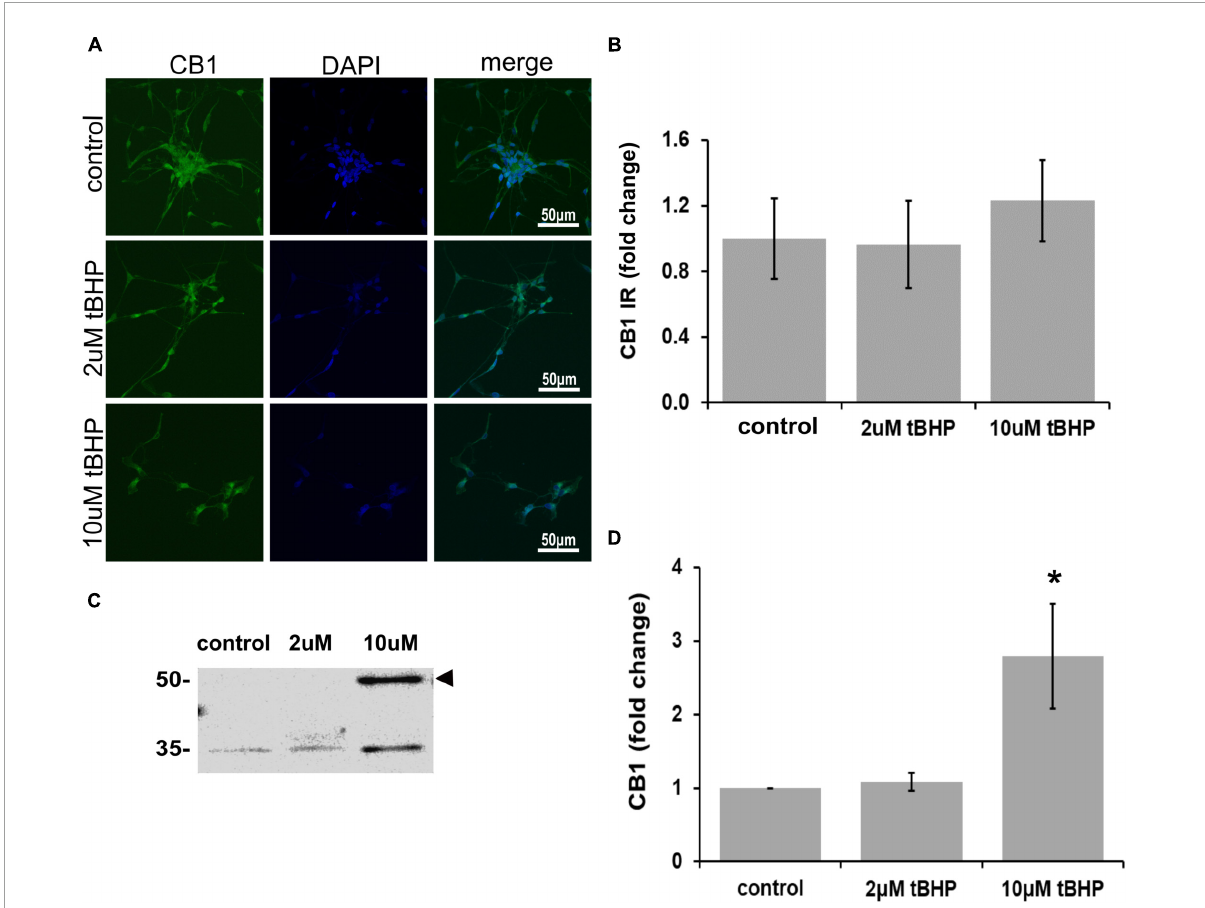
FIGURE2 Expression of cannabinoid receptor type 1 (CB1) in ReN cells under conditions of oxidative stress. CB1 immunoreactivity in differentiated ReN cells. (A) Images show that tert-butylhydroperoxide (tBHP) has no effect on CB1 IR (green). Green fluorescence is CB1 and blue fluorescence is DAPI-labeled nuclei. Images are 400 × magnification. (B) Quantitative analysis of images in panel (A) reveal that tBHP has no significant effect on CB1 IR, but a trend toward an increase exists (0.10 > p > 0.05). (C,D) Western blot analysis reveals that the expression of a 56 kDa band corresponding to CB1 is upregulated 2.8-fold by exposure to 10 µ M tBHP. * p ≤